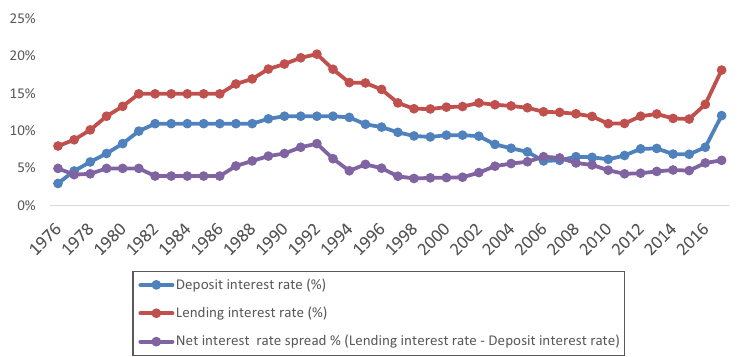
Figure 7. Net interest